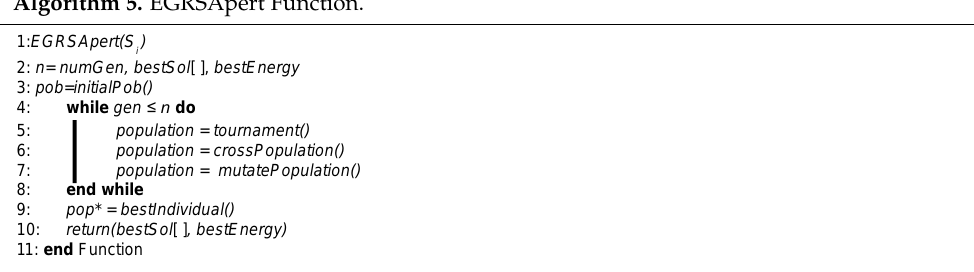
Algorithm 3 EGRSA algorithm Procedure